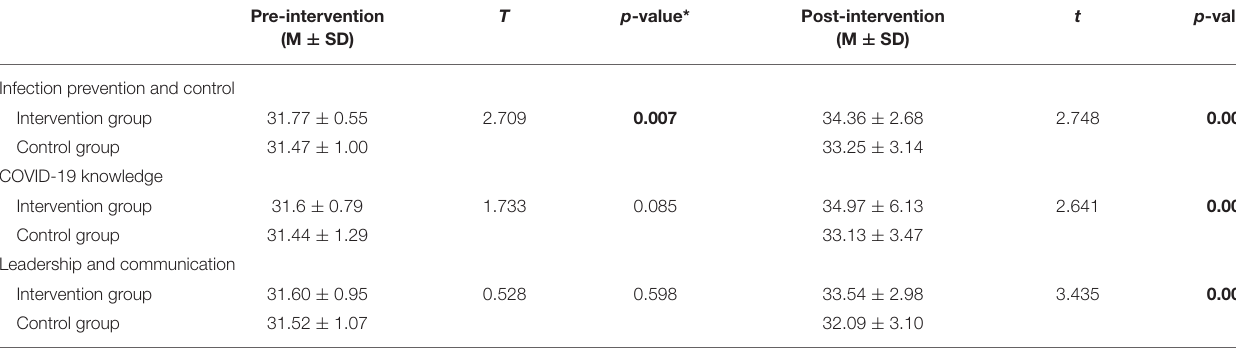
TABLE 3 | Mean results for the three intervention areas for the control and intervention group at pre- and post-intervention ( n = 208).